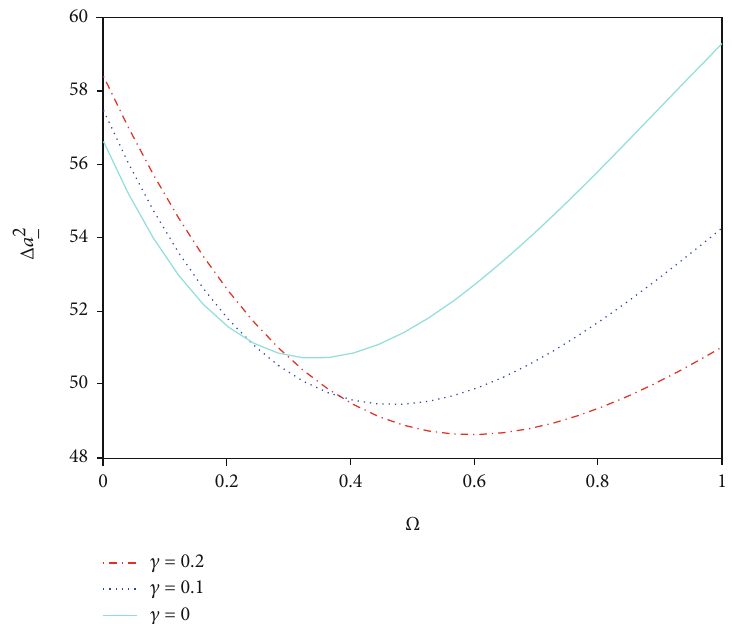
Ω for γ = 0 : 4 , k = 0 : 8 , N = 50, and for di ff erent values of γ . c